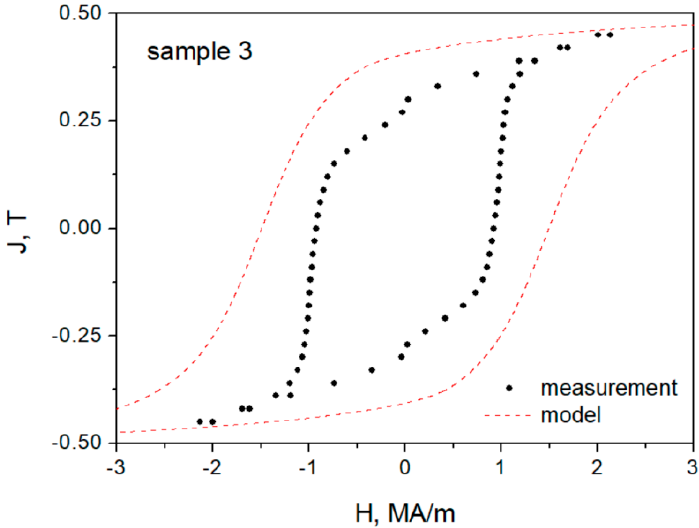
Figure 11. Modeled and measured hysteresis curves for Sample 2.